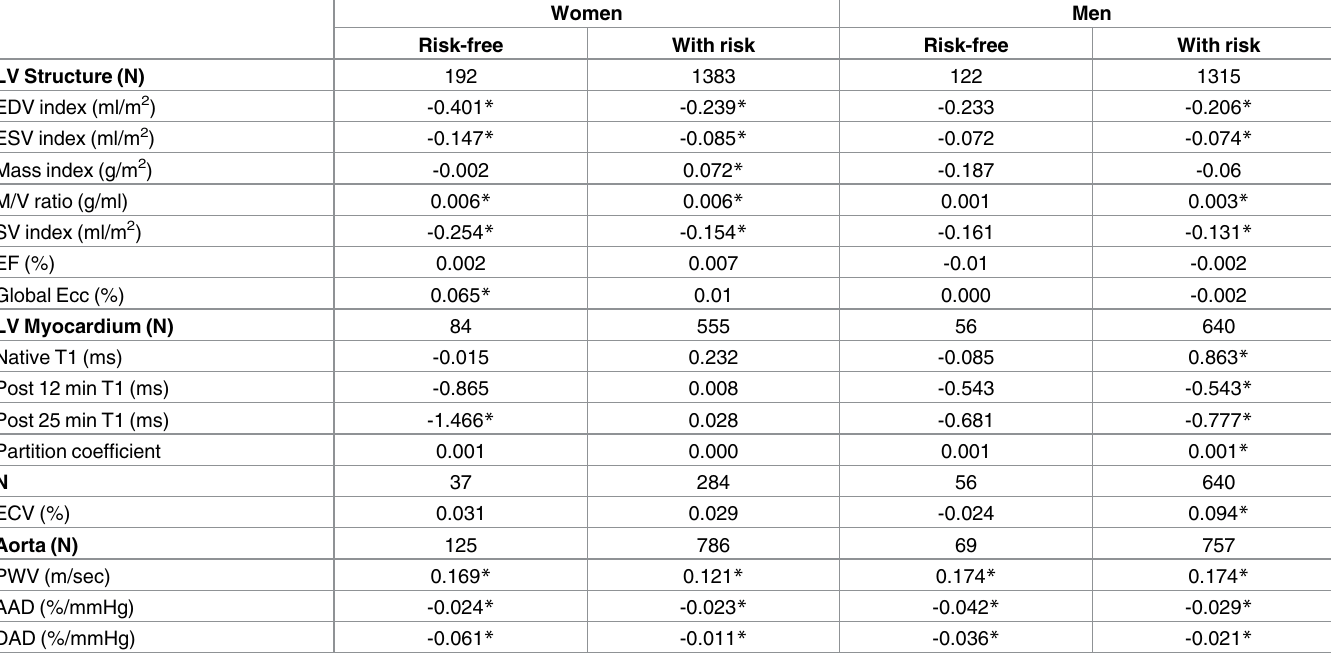
Table 3. The relationship of age with left-ventricular(LV) structure/function and aortic function in men and women with and without traditional risk factors. Univariateregression coefficient which representschange in the dependent variableper one-yearincreasein age. * for p <